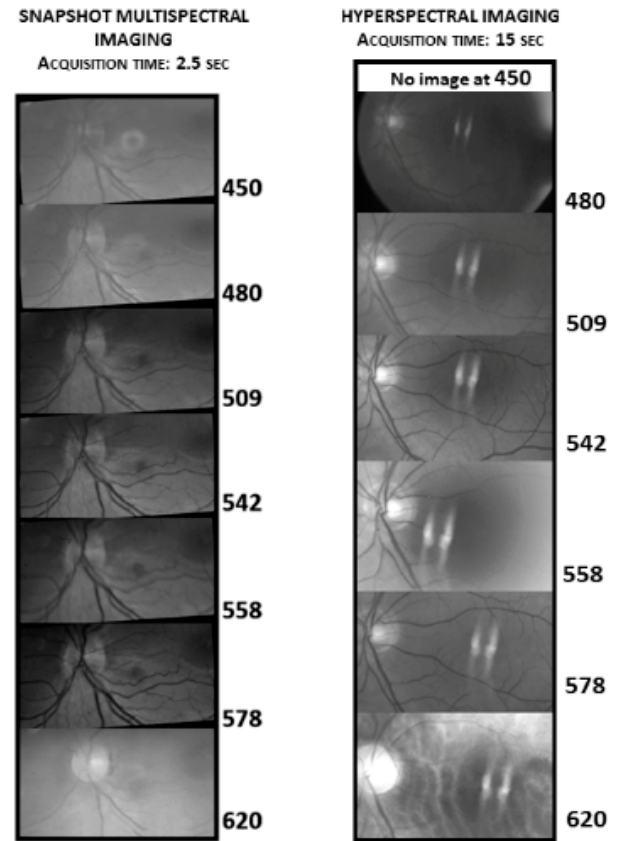
Figure 3. Comparison of ocular fundus images captured with MSI and HSI. The two bright white lines in all of the HSI wavelength images in the macula are specular reflections.